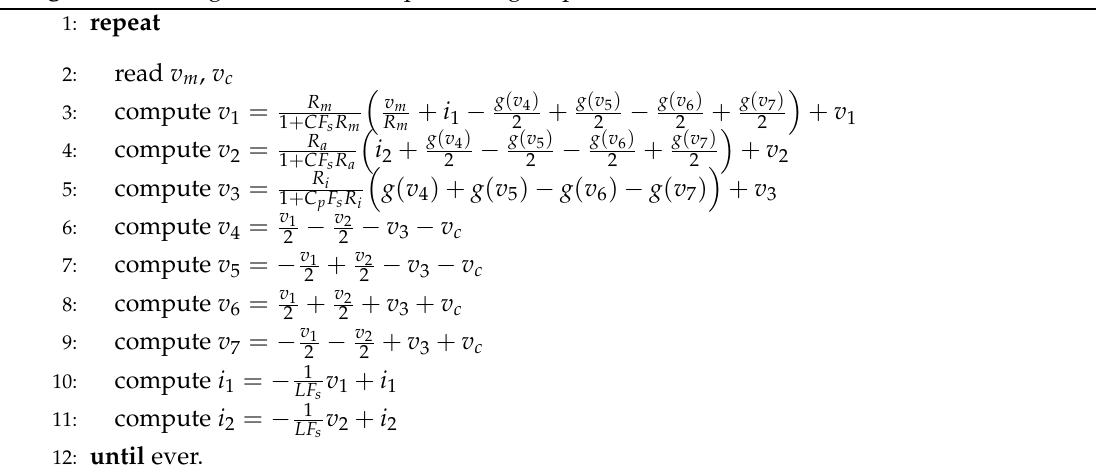
Algorithm 1: Ring modulator core processing loop.